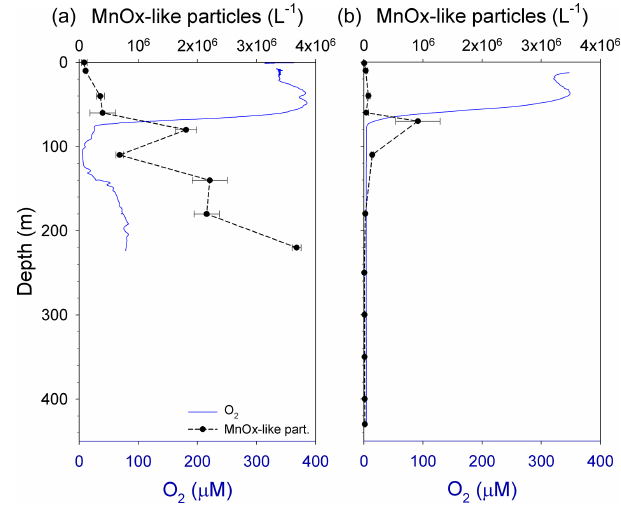
Figure 4. Vertical profiles of MnOx-like particles and O 2 concen- tration in the water column at the location of the sediment trap de- ployments. (a) GB and (b) LD. Grey lines as in Fig. 3.